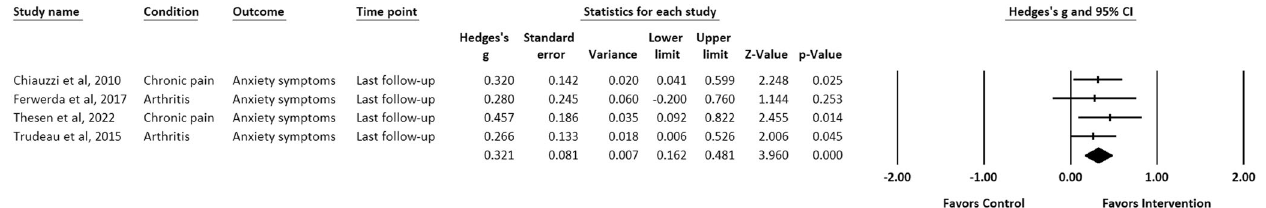
Fig. 9 Forest plot for effect sizes of IM-CBT on anxiety symptoms at last follow-up.